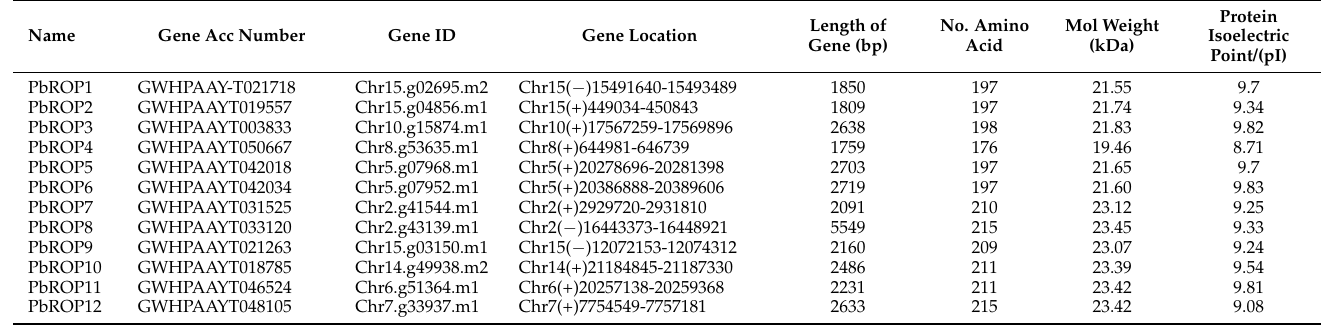
Table 1. Characteristics of the 12 PbROP genes of ‘ Duli ’ pear ( Pyrus betulifolia Bunge).